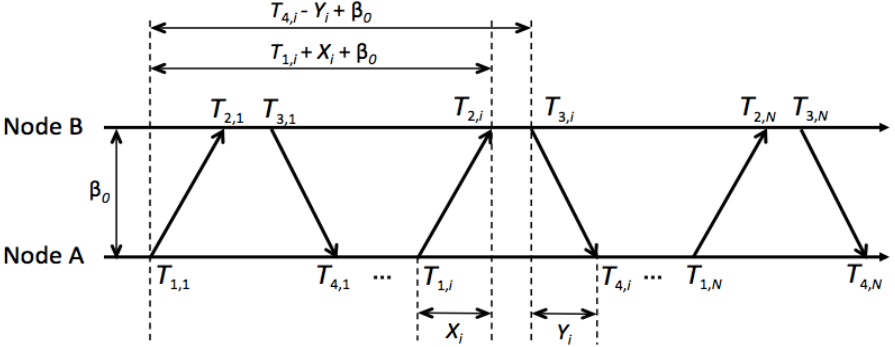
Figure 2. Two-way message exchange for diffusion-based clock synchronization between two nanomachines, node A and node B.